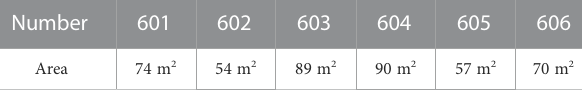
TABLE 4 Room area of households on the 6th fl oor of building 3#.